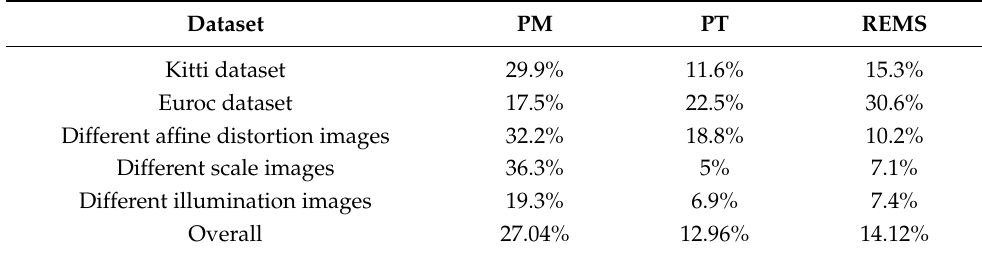
Table 6. Comparison of matching results of different illumination